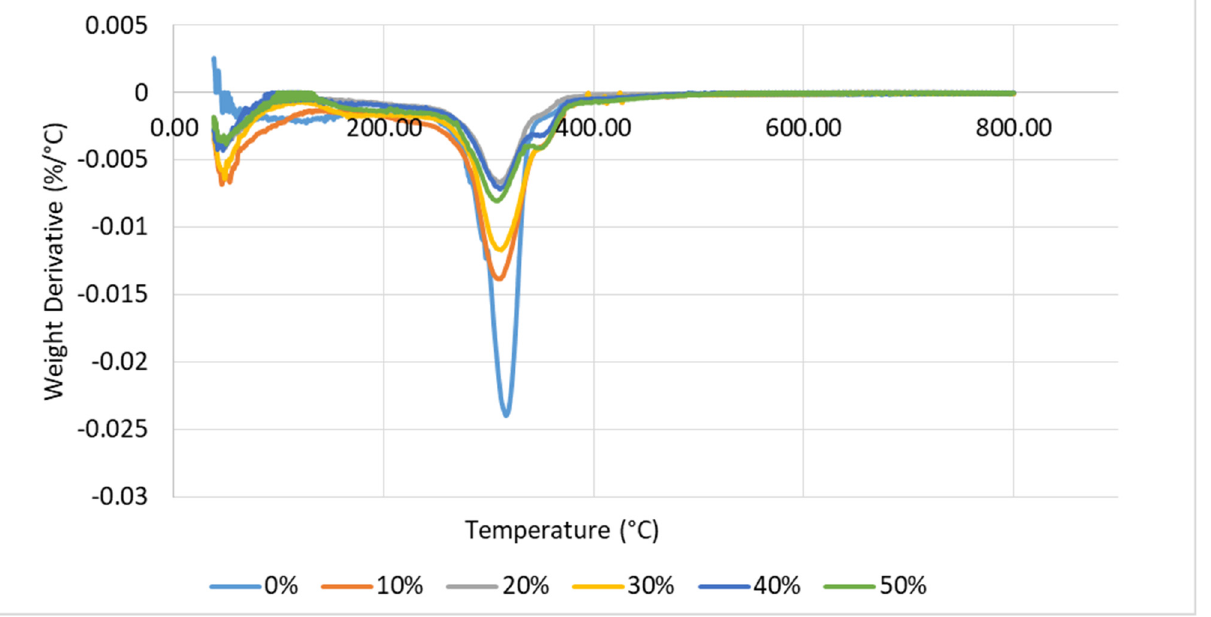
Figure 3. DTG curve of TPCS-banana leaf fibre.